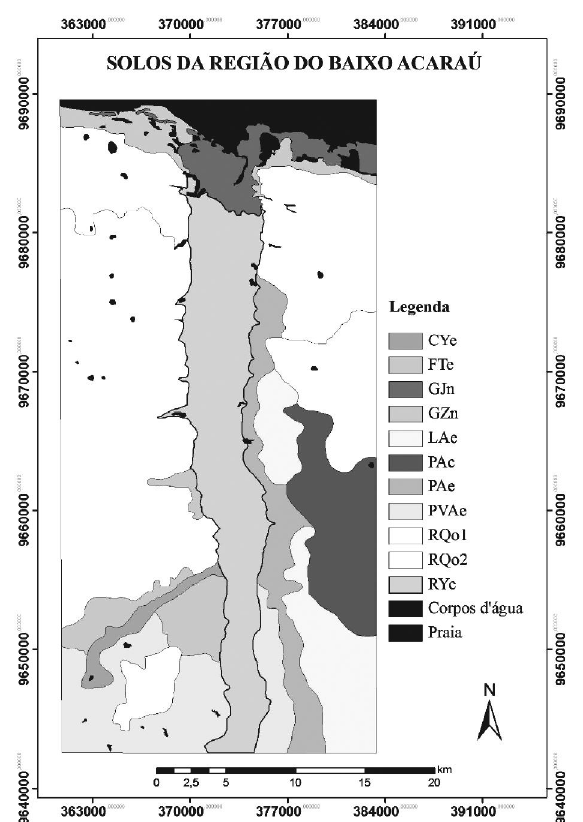
Figura 2. Mapa pedológico da região do Baixo